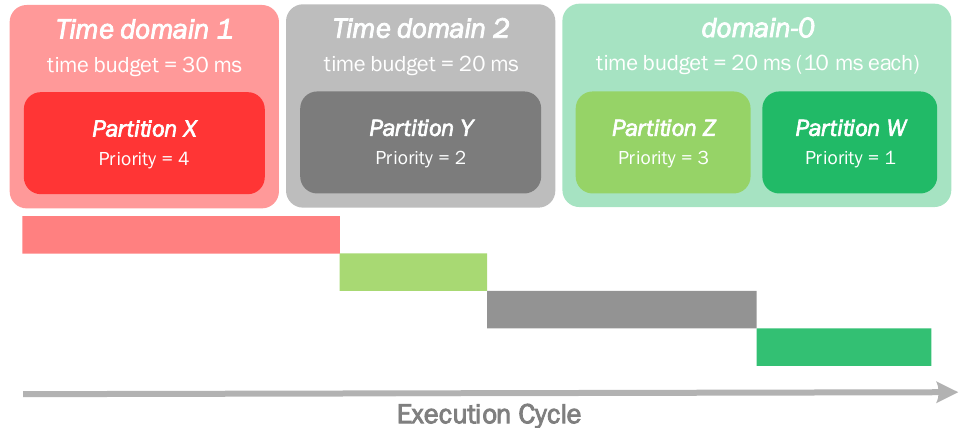
Figure 5. Example of an execution cycle, given a set of time domains with their own partitions and respective